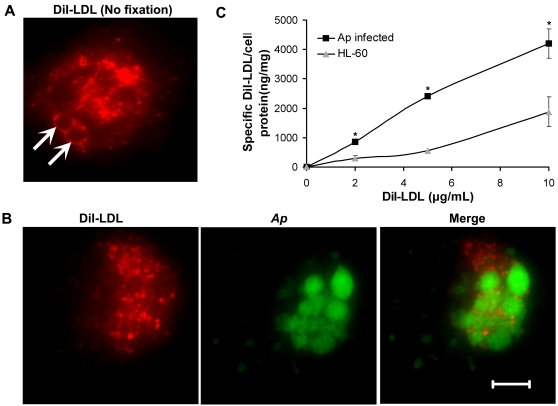
DiI-LDL uptake is enhanced upon A. phagocytophilum infection in HL-60 cells.Uninfected and A. phagocytophilum–infected HL-60 cells were incubated with increasing concentrations of DiI-LDL at 37°C for 2 h. After DiI-LDL uptake, HL-60 cells were directly observed by fluorescence microscopy without fixation (A), or after being fixed and labeled with anti–A. phagocytophilum (B). Arrows indicate A. phagocytophilum inclusions. Ap, A. phagocytophilum. The amount of cell-associated DiI was determined by fluorometric assay. Data were normalized to total cellular protein, and specific association was determined by subtracting the fluorescence measured in the presence of a 30-fold excess concentration of unlabeled LDL from normalized cell-associated DiI fluorescence (C). Data are expressed as mean±standard deviation (n = 3) and are representative of two independent experiments. *, p<0.05 (unpaired two-tailed t test); **, p<0.01 (unpaired two-tailed t-test).